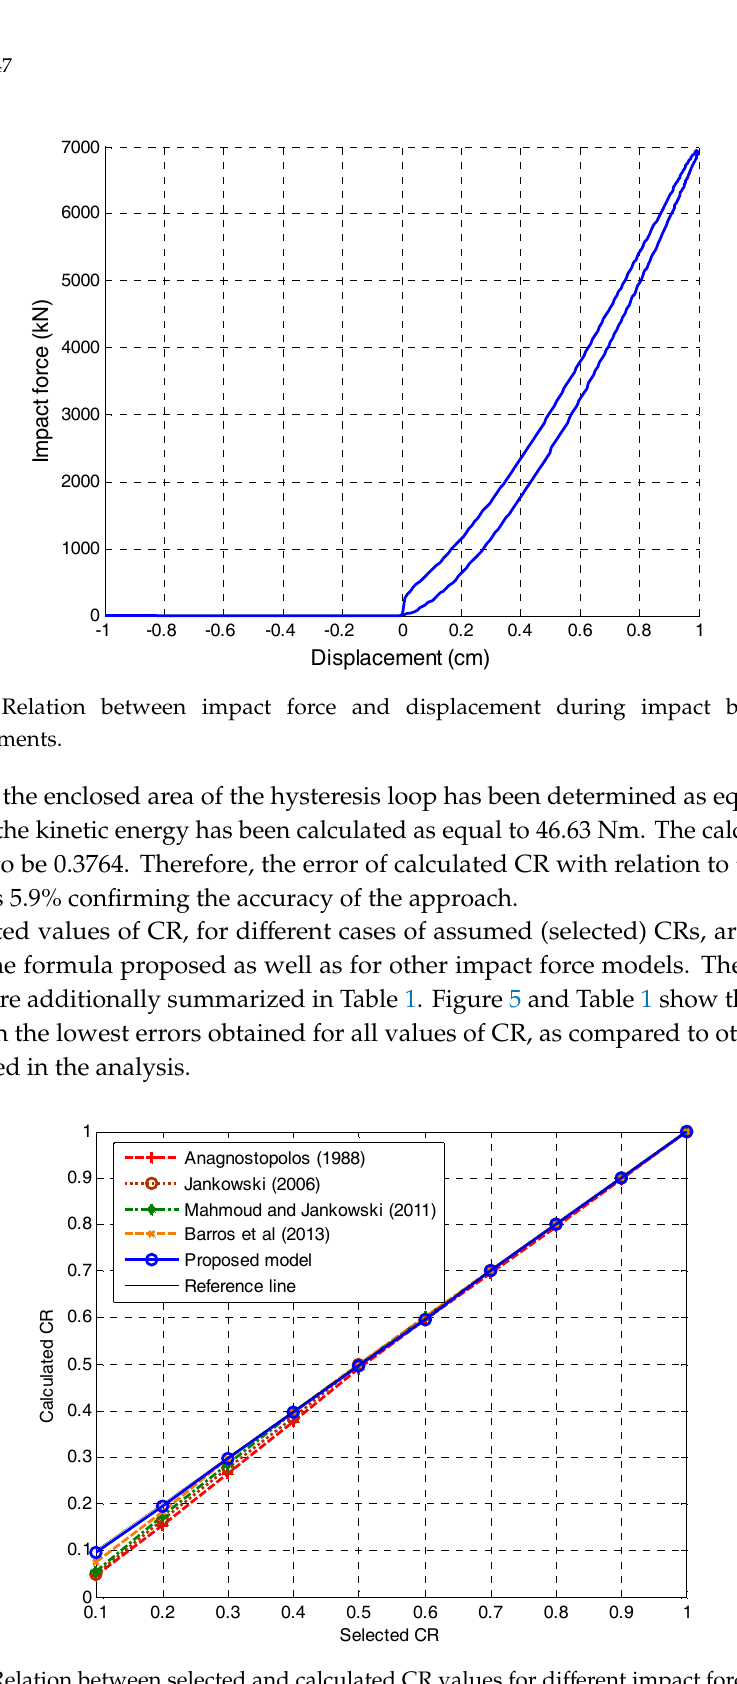
Figure 5. Relation between selected and calculated CR values for different impact force models. Table 1. Errors between selected and calculated CR values for different impact force models.